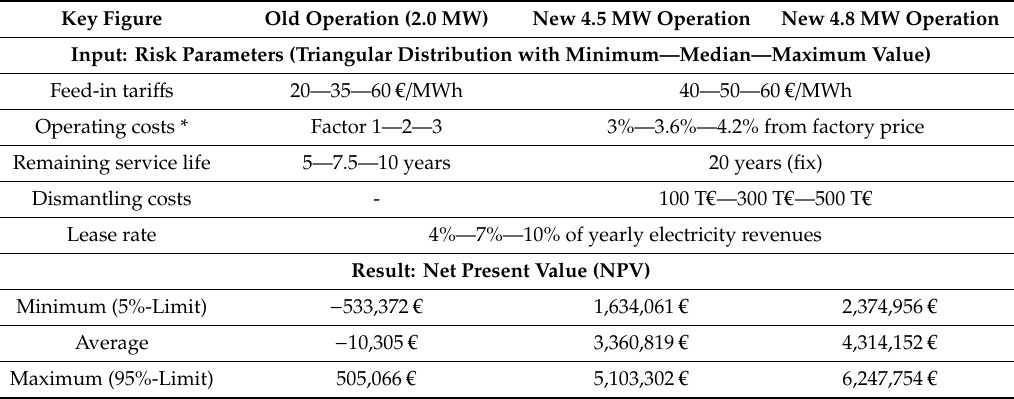
Table 4. Net present value (NPV) for three wind turbines with variable remuneration, operating costs, dismantling costs, and leasing rate; stochastic simulation with 10,000 repetitions.